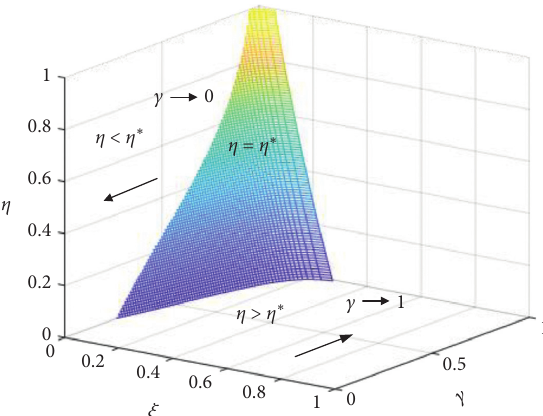
Figure 4: Evolutionary phase diagram of consumer’s strategy selection.